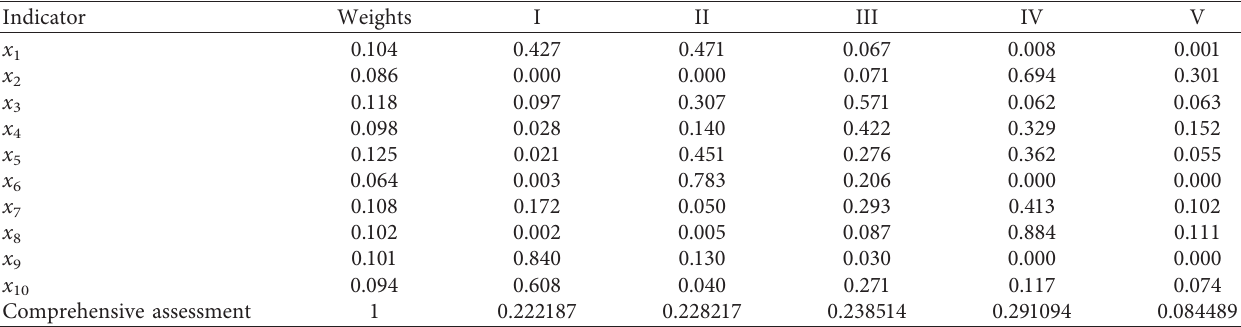
Table 12: The comprehensive assessment level of the